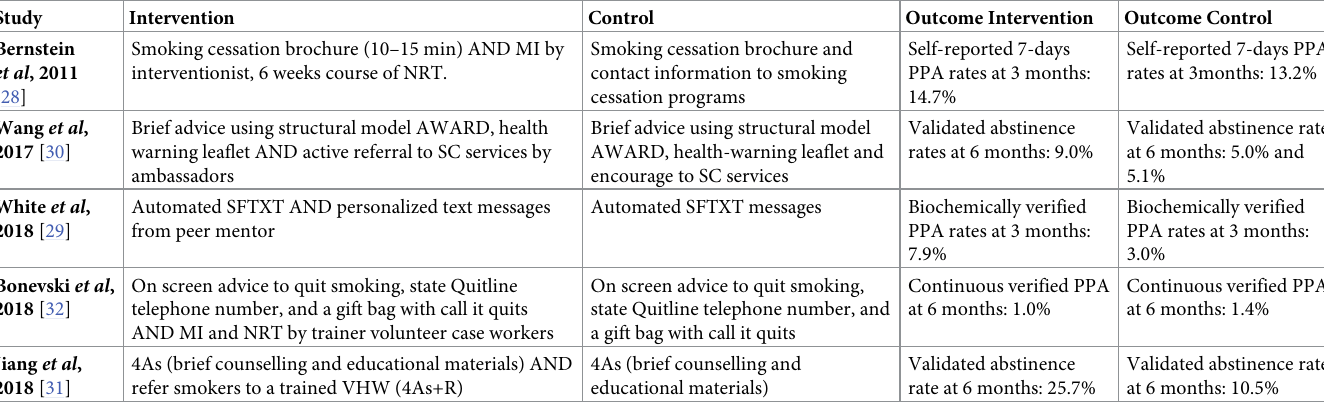
Table 2. Characteristic of intervention and